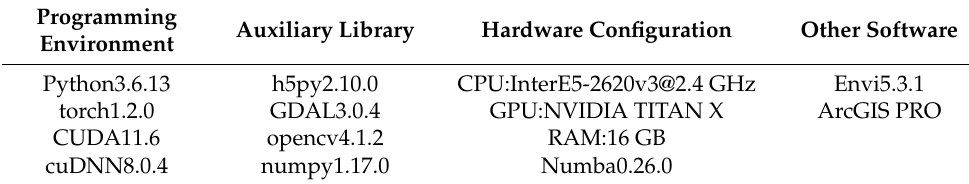
Table 3. Environmental configuration.